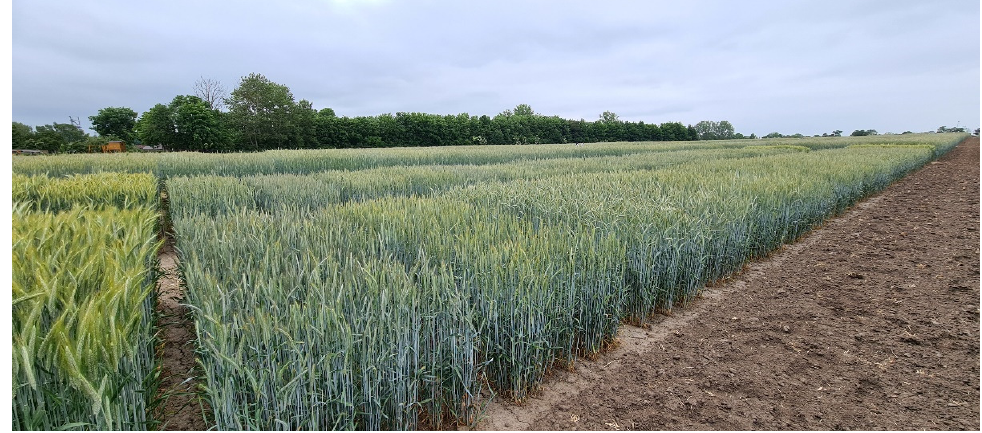
Figure 10. Survey on the first 48 gibberellin-sensitive semidwarf P-type CMS rye